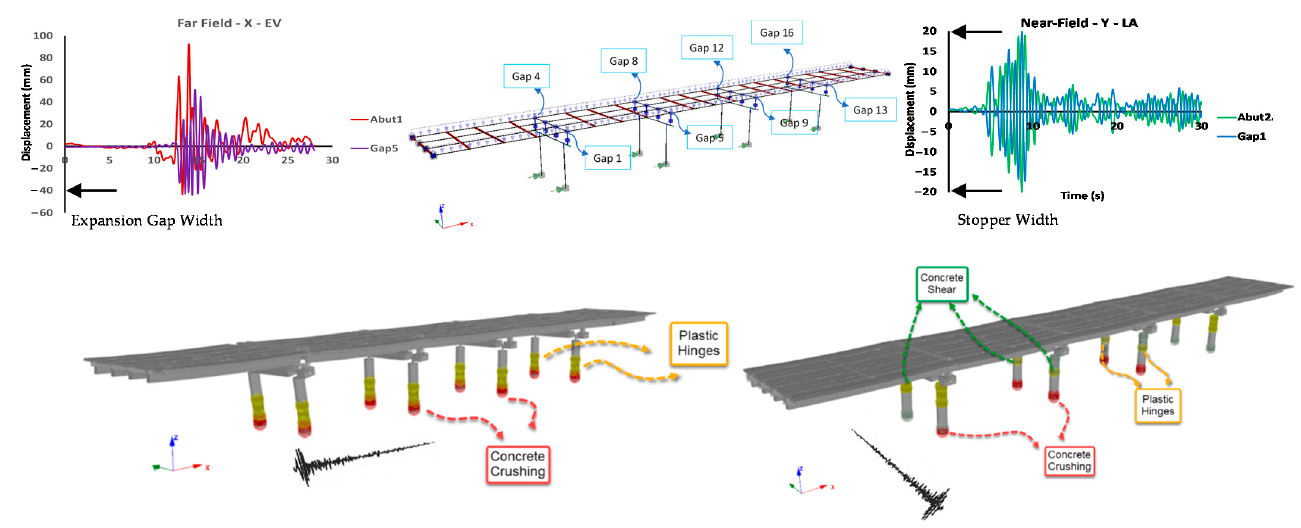
Figure 16. Bridge damage locations under earthquakes in the longitudinal ( left ) and transverse ( right ) directions—design